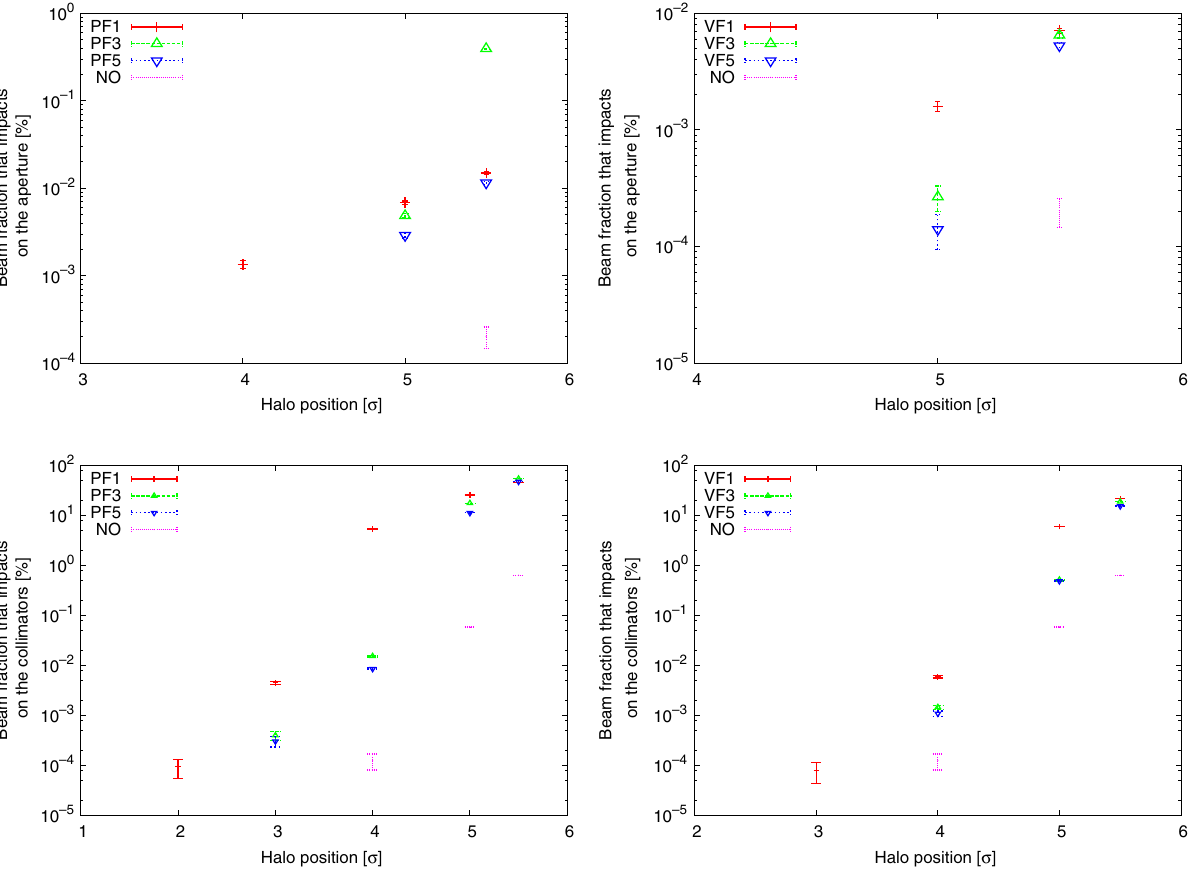
FIG. 10. Beam fraction that impacts on the aperture (top) and collimators (bottom) considering horizontal halos at different sigma positions with a smear of 0 . 1 σ , for the PF (left), VF (right), and NO (in all the plots)